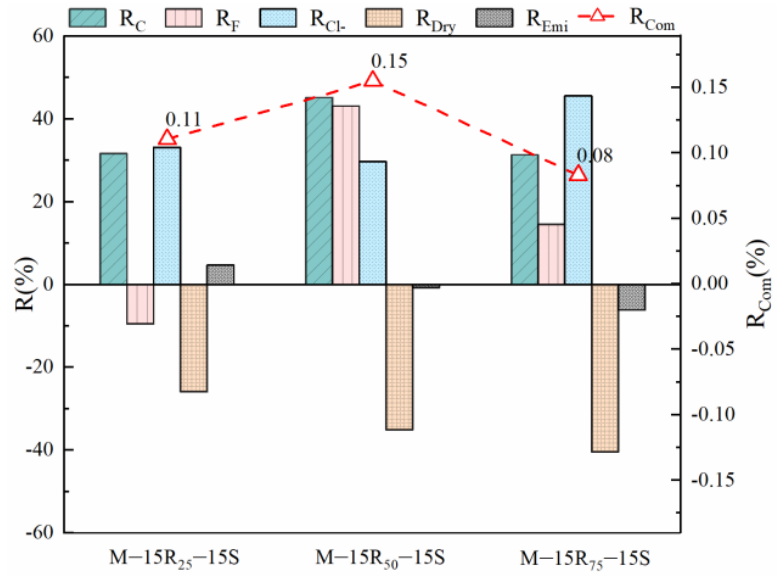
Figure 10. Fundamental properties of eco-efficient mortar in Series B.